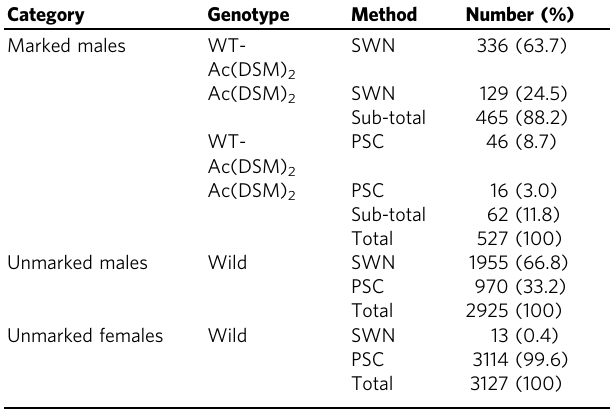
Table 2 Numbers of marked males and unmarked wild males and females of A. gambiae s.l. recaptured during the 20 days of the MRR (Mark-Release-Recapture) study in relation to collection